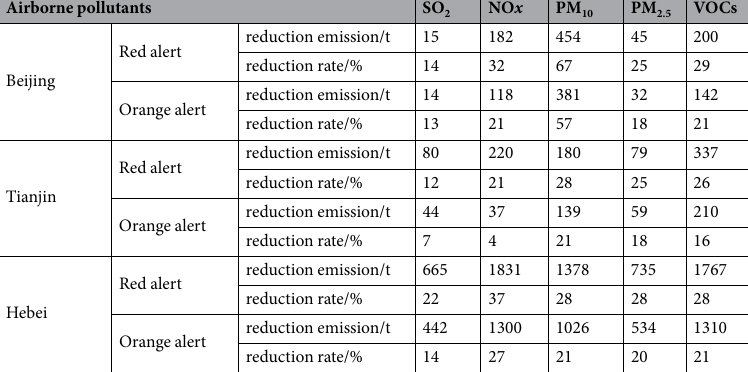
Table 4. Daily averaged emission reductions of SO 2 , NO x , PM 2.5 , PM 10 , and VOCs in the Beijing-Tianjin-Hebei region.